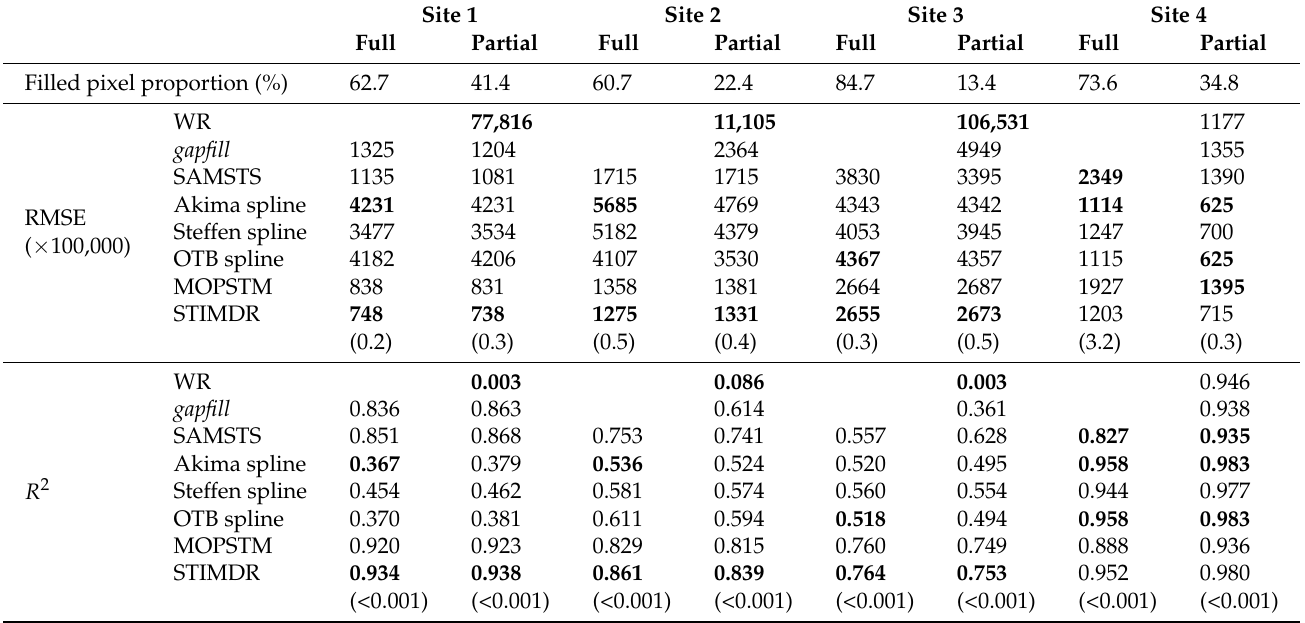
Figure 6. Comparison of pixel-based RMSE (multiplied by 100,000) of gap-filled images using different methods for the four sites. The pixels were from the common regions that have been filled by these methods. Table 3. Comparison of WR, gapfill , SAMSTS, Akima spline, Steffen spline, OTB spline, MOPSTM, and STIMDR performance evaluated by RMSE (Equation (7)) and R 2 for seven bands of single-date Landsat 8 images in the four sites. The highest and lowest values are presented in bold. The values in the parentheses under STIMDR results are the standard deviation of the 10 repeated experiments. The “Full” filled pixel proportion approximately equals the proportion of all gaps in the target images, and the “Partial” pixel proportion equals the common pixels that have been recovered by all